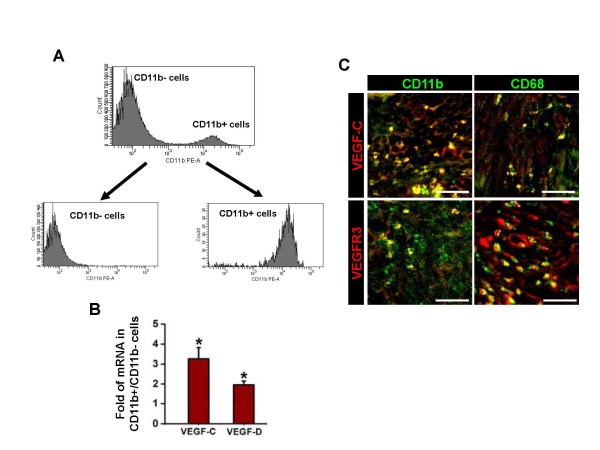
CD11b+ or CD68+ TAM abundantly express VEGF-C/D and VEGFR-3. 1 × 106 MBT-2 cells were injected into the urinary bladders of 8-10-week old female C3H mice. 4 weeks after the tumor cell injection, single cell suspension of OUBC was prepared. (A) CD11b+ cells and CD11b- cells were enriched by FACS with ~95% purity. (B) Comparison of mRNA expressions of VEGF-C/D in CD11b+ cells. Data are presented as relative fold to CD11b- cells after standardization with hypoxanthine-guanine phosphoribosyl transferase (HPRT). Graph shows mean ± SD; n = 3 for each group. *p < 0.05 versus CD11b- cells. (C) Images showing CD11b+ or CD68+ TAM and VEGF-C+ or VEGFR-3+ cells in the sectioned samples. Scale bars, 50 μm.